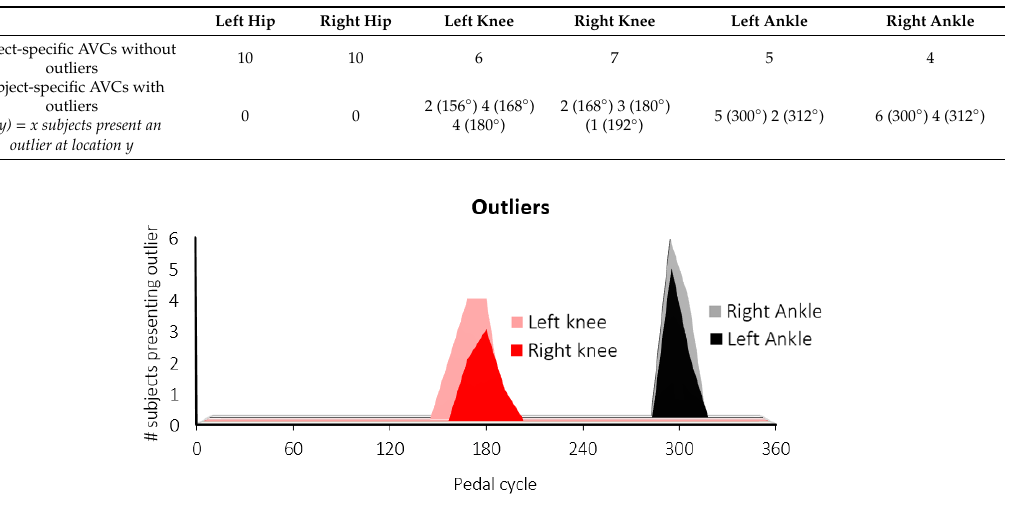
Figure 7. Visual comparison of the number of subjects with outliers for a certain joint in function of the pedal